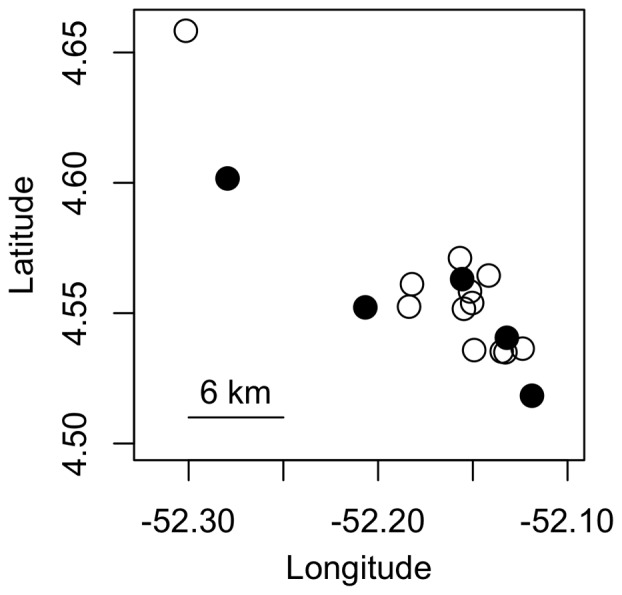
Map of nest locations showing 18 of the nests used in this study.Black circles represent Cr. levior Type A, and white circles represent Cr. levior Type B nests.